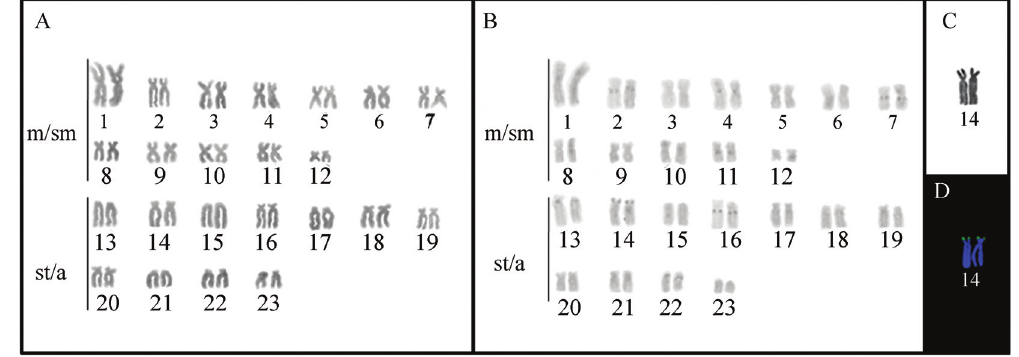
Figure 2 - Karyotype of Sparisoma radians (2n = 46) after Giemsa staining (A) and C-banding (B). The NOR-bearing pair is shown in detail after silver nitrate (C) and fluorochrome staining (D) revealing CMA 3 + sites coincident with NORs.